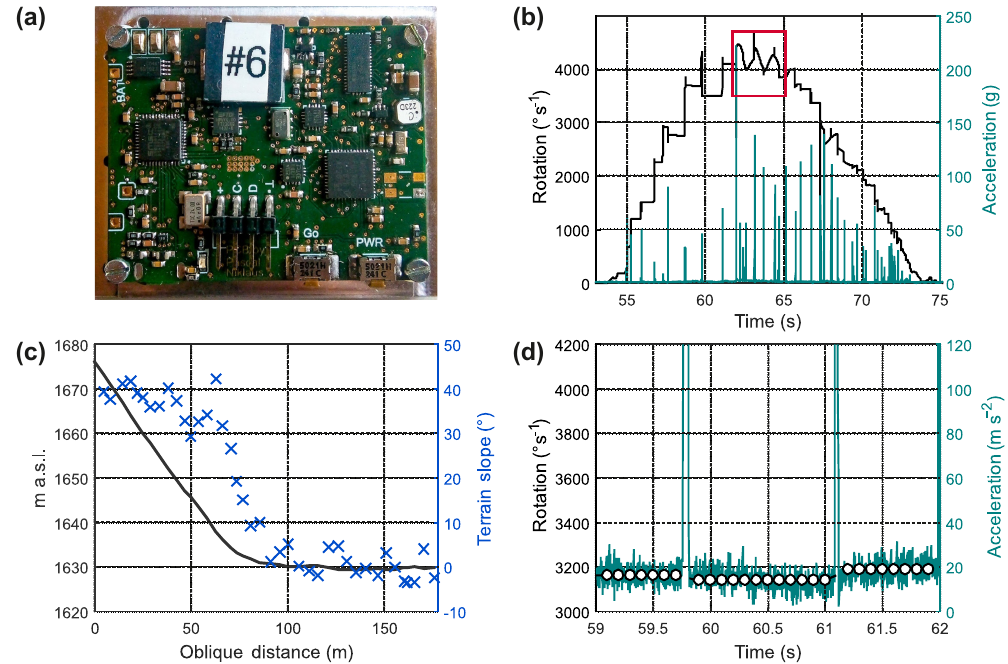
Figure 1. (a) An exposed micro-controller board hosting all the MEMS sensors, microSD card and a USB connector powered by a 1100mAh battery (both covered by the board). (b) Sensor data stream showing absolute rotational velocities and acceleration values during the 20s movement phase (from 54 to 74s), the rectangle indicating range with one saturated axis. (c) Slope distance of the projected trajectory of the stone with its location and slopes. (d) Absolute rotational velocities and acceleration values, plus mean acceleration values within the intervals of impacts (white dots) for calculating